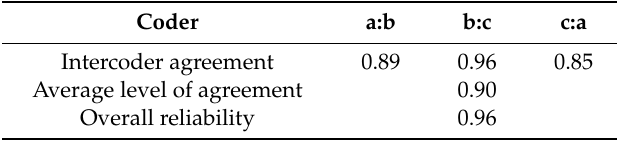
Table 4. Intercoder agreement and